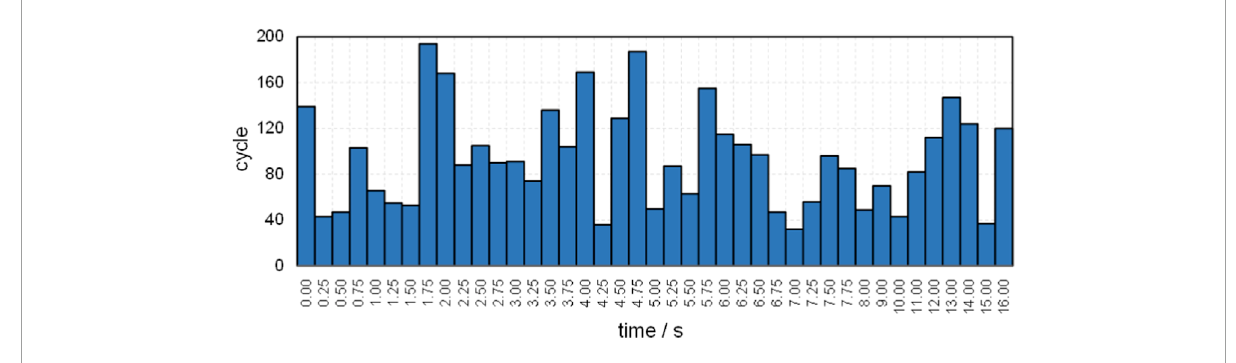
FIGURE 4 The convergence cycles of TD4-4, given by Eq. 28 .